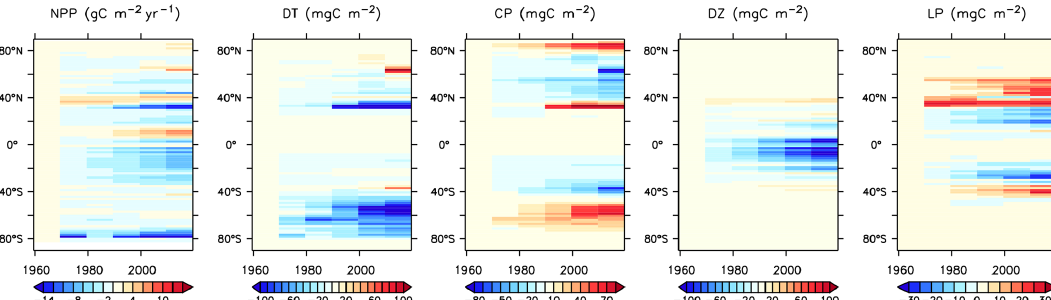
Figure 18. Modelled historical changes in zonally averaged and depth-integrated NPP, and phytoplankton biomass, from 1964 to 2014.